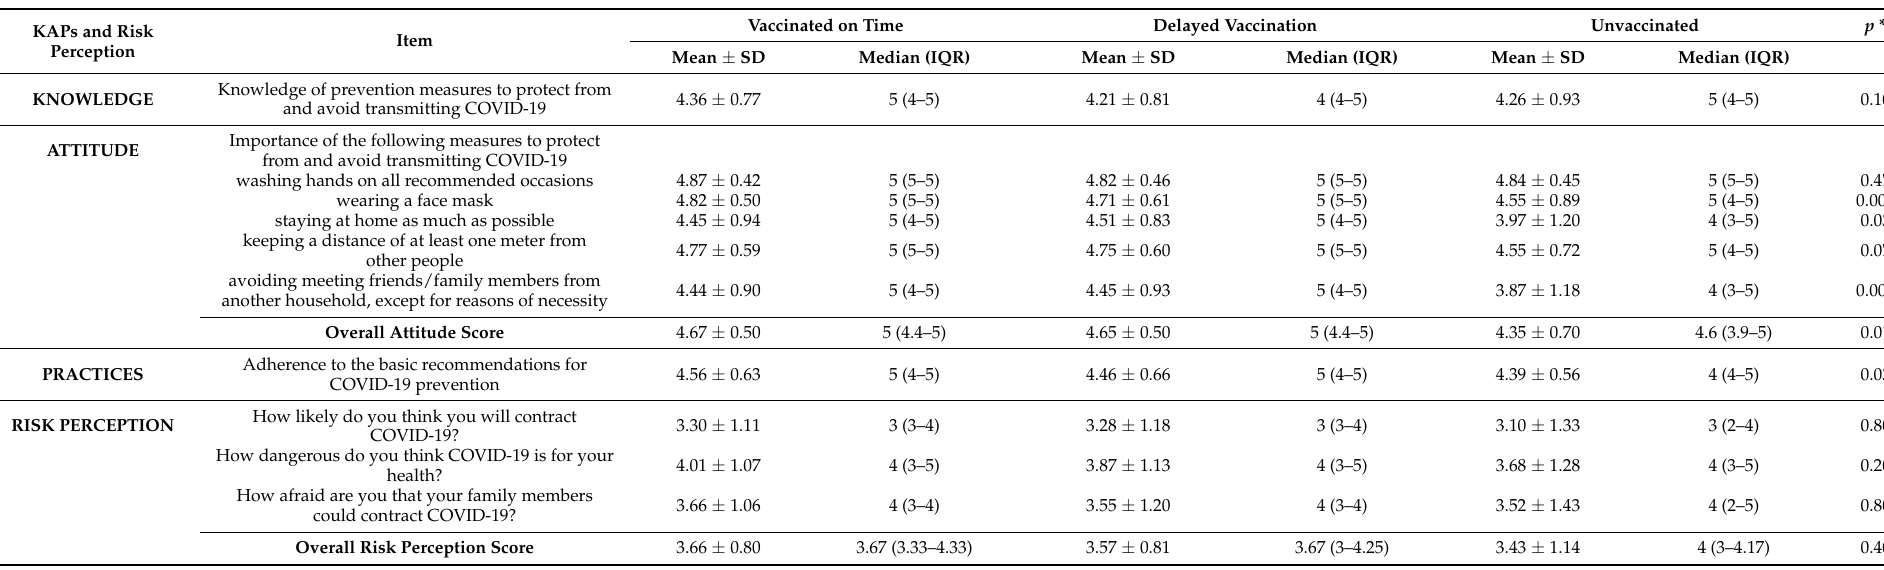
Table 4. Knowledge, attitudes, and practices towards COVID-19 preventive measures and COVID-19 risk perception of the whole sample and in the three vaccination subgroups (vaccinated on time, delayed vaccination, and